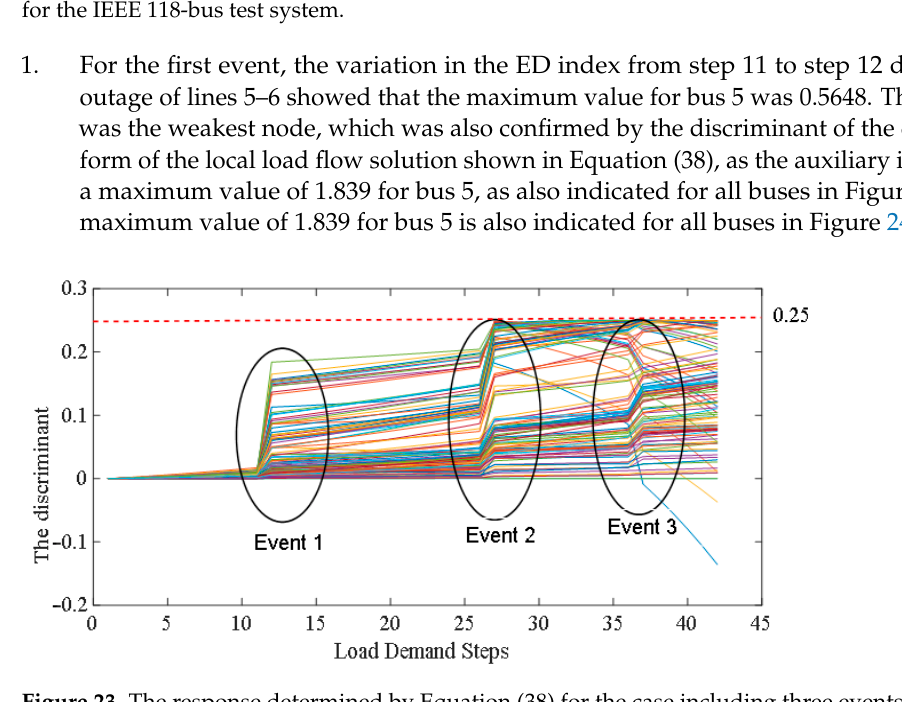
Figure 23. The response determined by Equation (38) for the case including three events related to